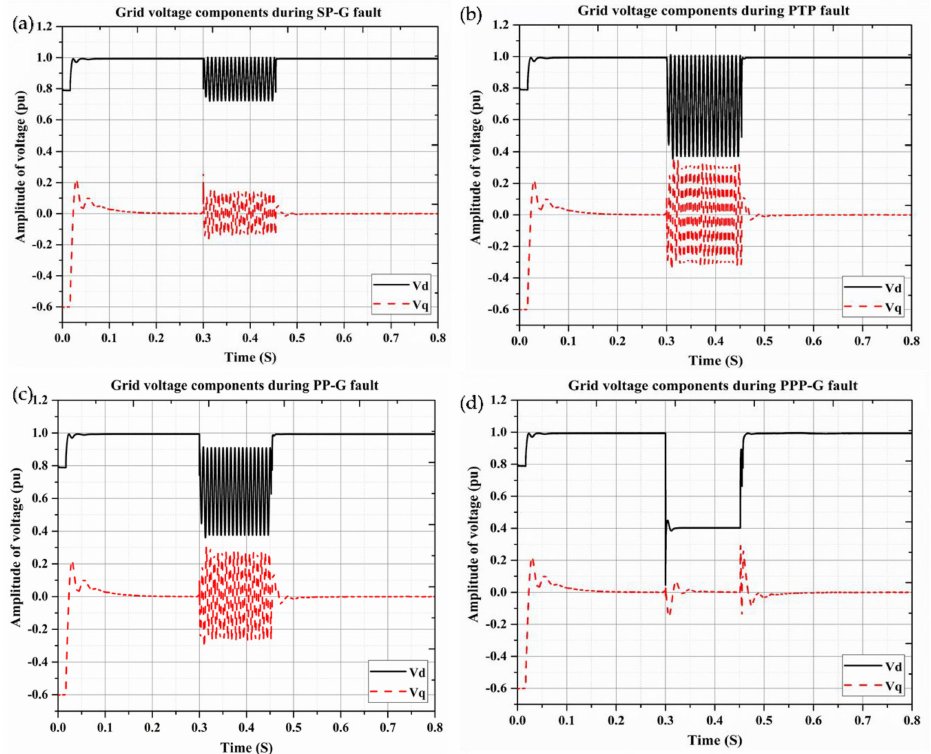
Figure 7. ( a – d ) The Vd and Vq grid voltage components during grid